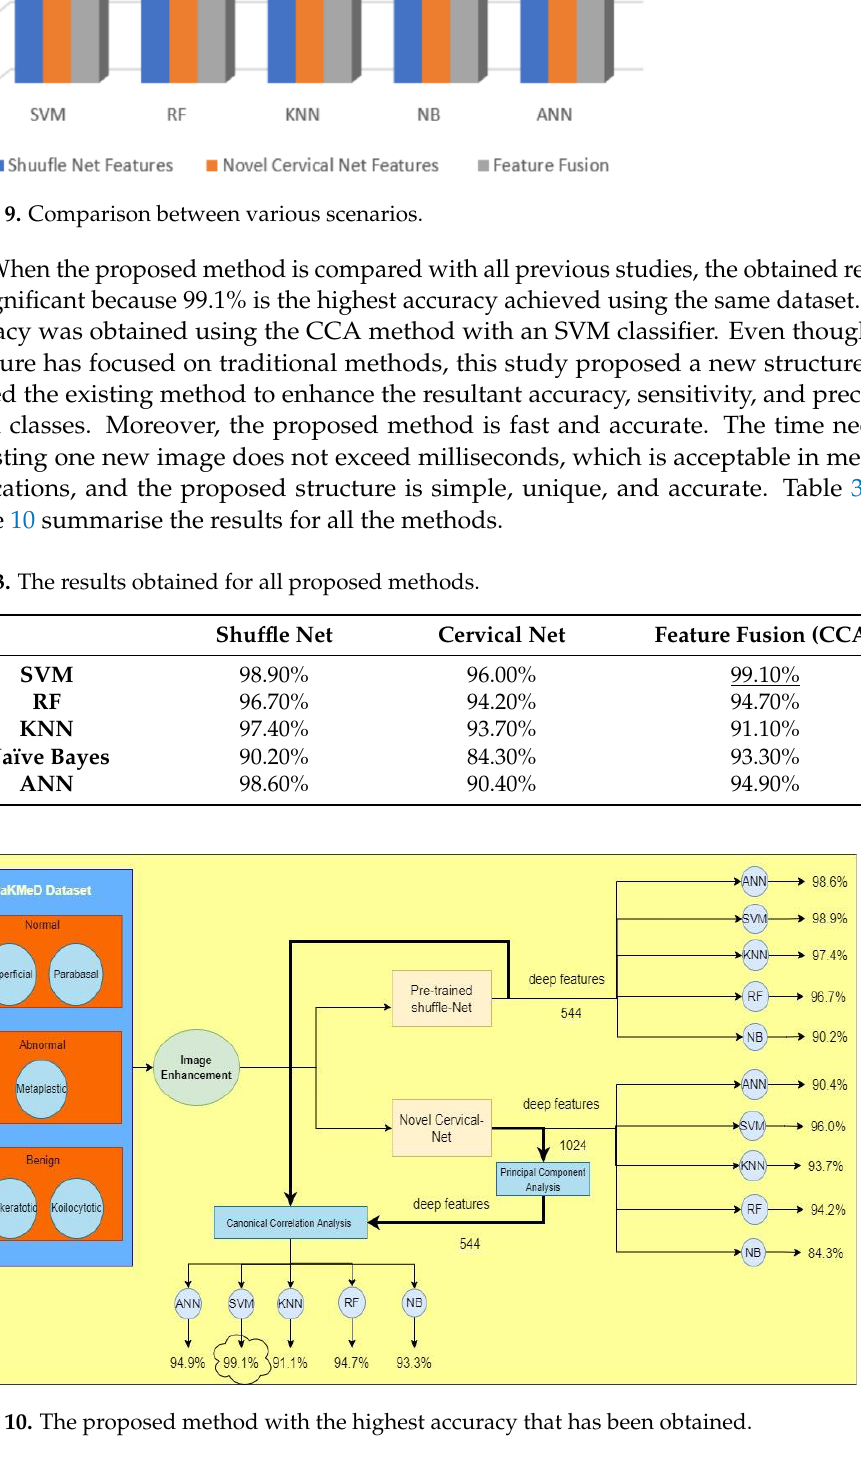
Table 4. Comparison of the proposed method with previous studies.